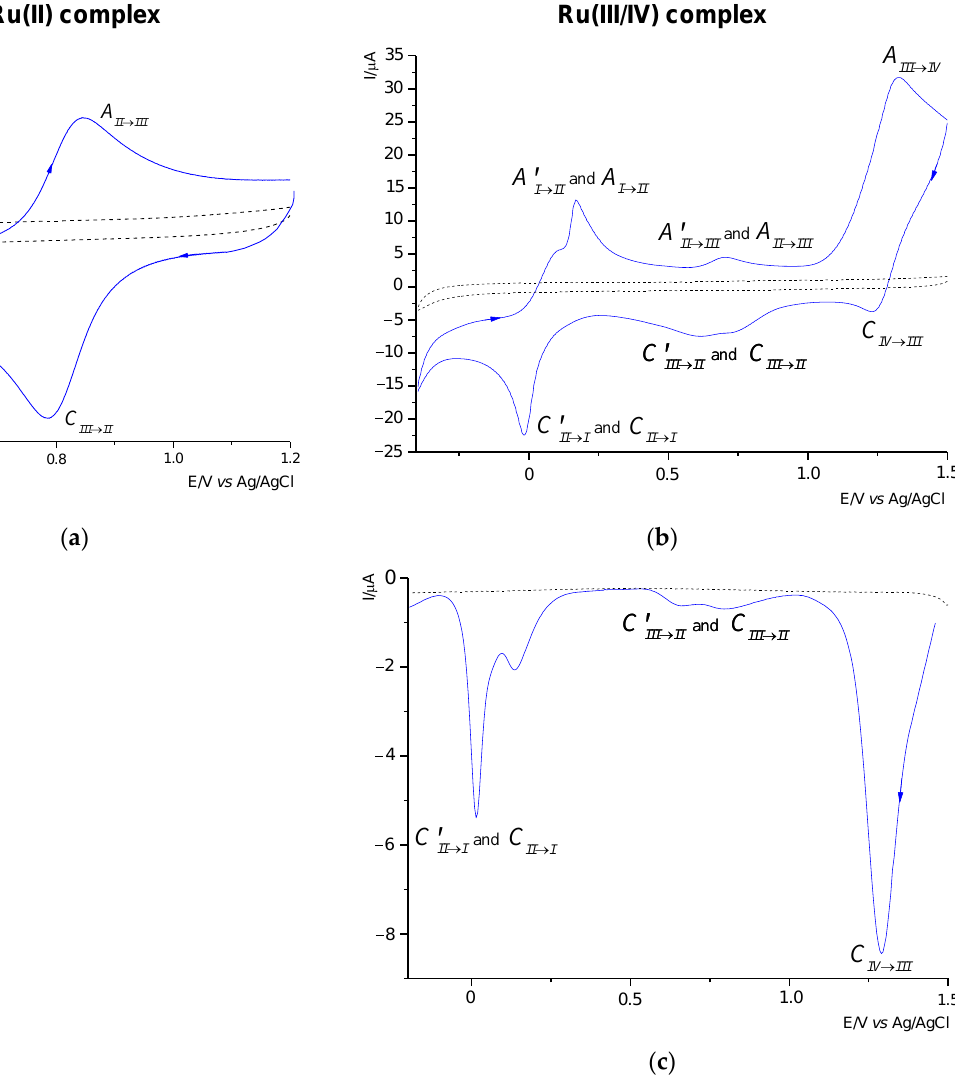
Figure 4. CV ( a , b ) and DPV ( c ) curves recorded in acetonitrile containing 0.1 M TBAPF 6 and 1 mM Ru(II) complex/Ru(III/IV) complex (—) or 1 mM ligands (---), (CV conditions: GCE, Ø = 2 mm, scan rate 100 mV/s, T = 25 °C; DPV conditions: CF, Ø = 33 µm, pulse amplitude 20 mV, pulse width 80 ms, scan rate 20 mV/s).